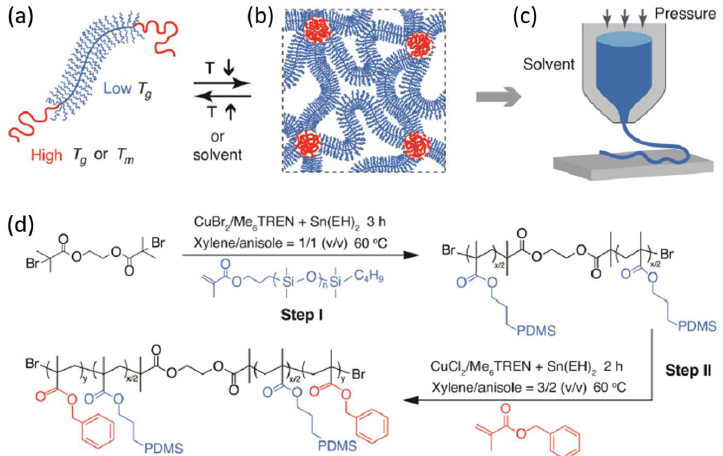
Figure 9. Design concept and synthesis of 3D printable, reversible, ultrasoft, and stretchable elas- tomers. ( a ) Schematic of a responsive linearbottlebrush-linear triblock copolymer. ( b ) At low tem- perature, the middle bottlebrush blocks (blue) act as elastic network strands, whereas the high Tg end linear blocks aggregate to form spherical glassy domains. ( c ) Glassy domains dissociate at high temperature or in the presence of solvents, resulting in a solid-to-liquid transition of the network. The stimuli-triggered reversibility allows the elastomers for direct-write 3D printing. ( d ) Synthesis of linear-bottlebrush-linear triblock copolymers using ARGET ATRP. The side chain of the mid- dle bottlebrush block is linear polydimethylsiloxane (PDMS), whereas the end blocks are linear poly(benzyl methacrylate) (PBnMA). A bottlebrush-based triblock polymer is denoted as BnMAy-b- PDMSxw-b-BnMAy, in which y is the number of repeating BnMA units, x is the number of PDMS side chains per bottlebrush, and w represents theMW of PDMS side chains in kg/mol. The weight fraction of the end blocks in the triblock copolymer is kept below 6% to ensure that the bottlebrush-based ABA triblock copolymers self-assemble to a sphere phase. Reprinted with permission from [102].